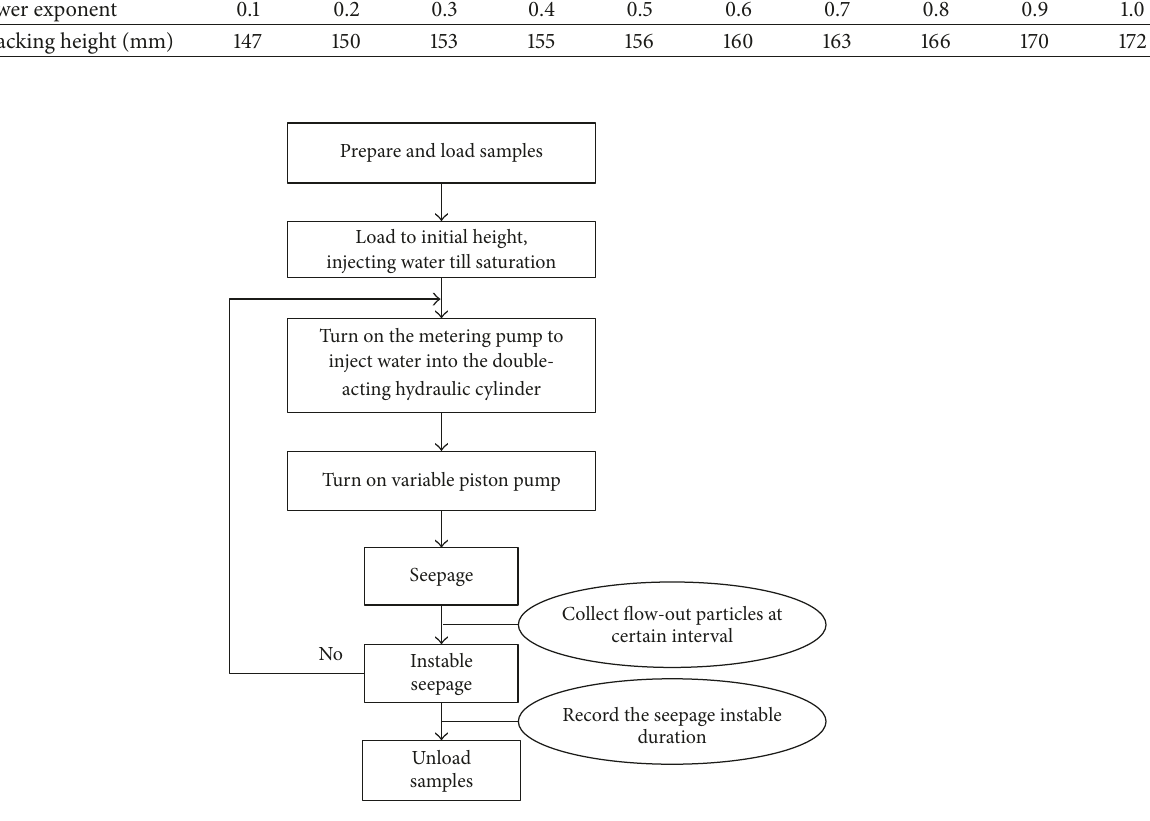
Figure 3: Flow chart of the